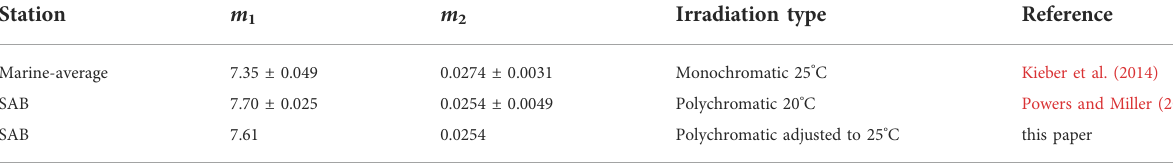
TABLE 1 Comparison between AQY parameters in Powers and Miller (2016) and the “ marine-average ” AQY parameters used in the global model. For monochromatic irradiations, AQY parameters were derived by a nonlinear regression of AQY versus λ . Uncertainties listed for m 1 and m 2 represent the margin of error with 95% con fi dence level. For polychromatic data, the parameters were determined using a non-linear curve- fi tting routine in Matlab ® ( nlin fi t ), to solve for the best- fi t equation to describe all light treatment data.